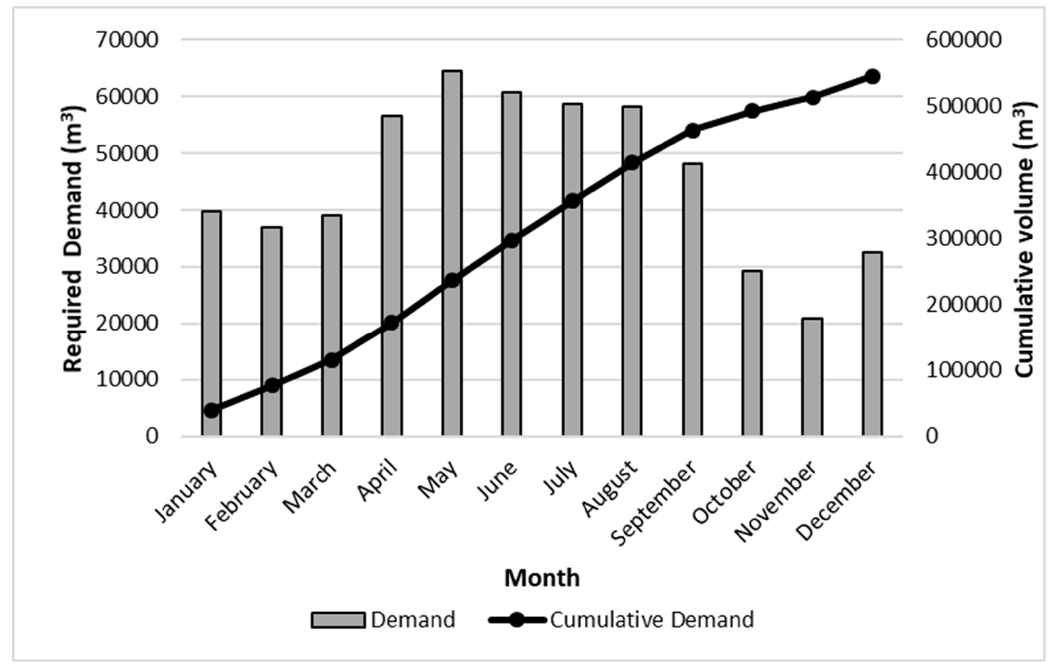
Figure 3. Data of the water demand according to [30].